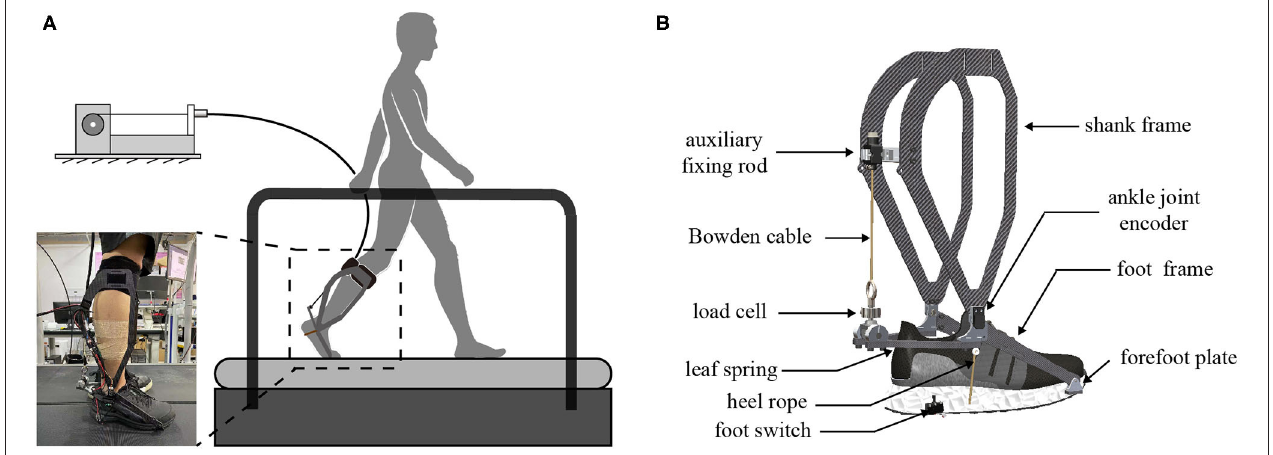
FIGURE 1 | (A) Schematic of the tethered ankle exoskeleton system for human walking assistance. (B) The mechanical structure of the ankle exoskeleton.